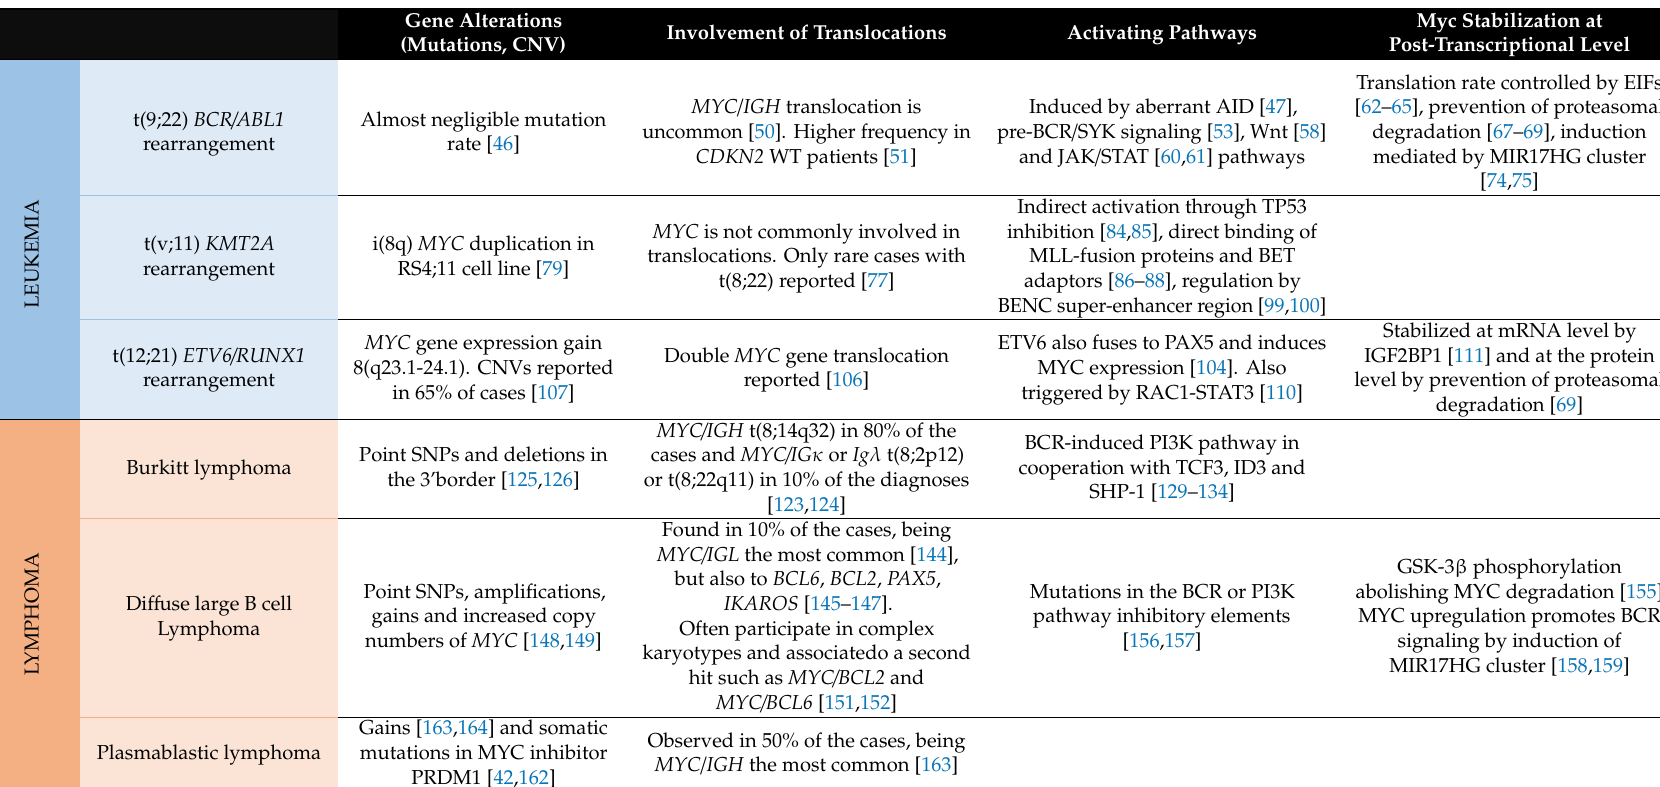
Table 1. MYC alterations in leukemia and lymphoma. Summary of the gene alterations, chromosomal translocations, regulatory pathways, and post-transcriptional modifications involved in MYC activation that are included in this review, assigned to their corresponding subtype of leukemia and